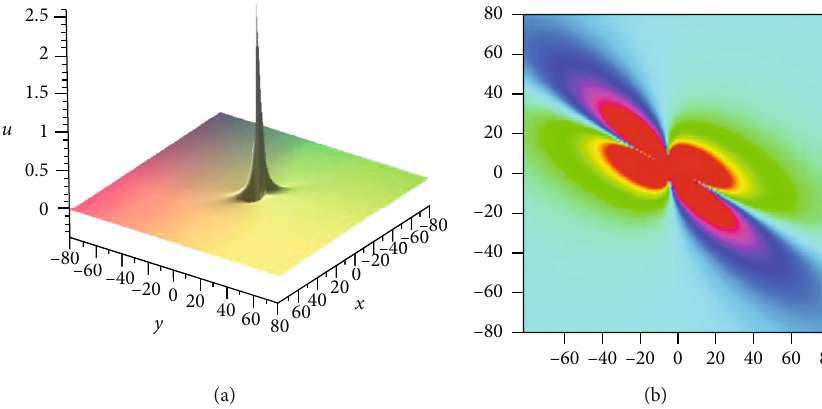
Figure 1: (a) The 1-lump solution u for cKP3-4 equation (2). (b) Density plot of (a).